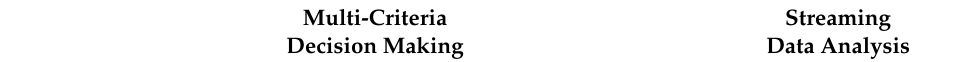
Table 1. Data Processing methods (Stage